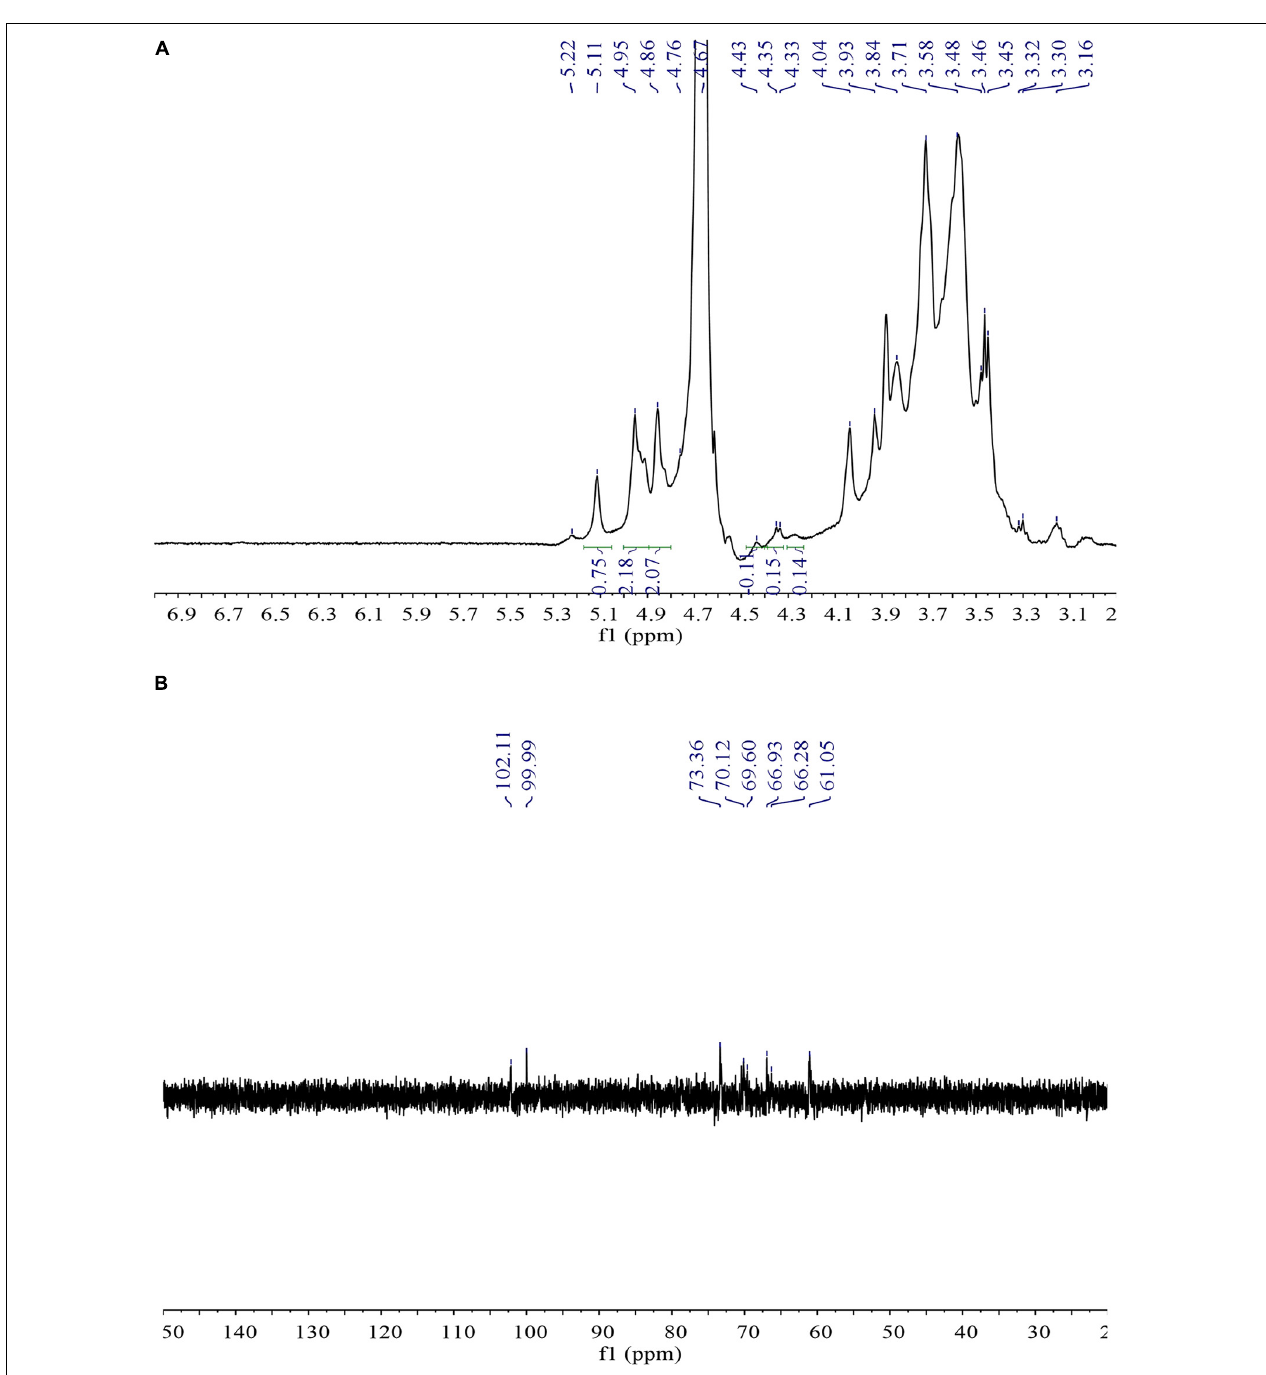
has been shown in Supplementary Figure 2 . The sharp and broad peak around 3,406.59 cm − 1 could be attributed to O–H stretching vibration. The signal at 1,652.69 cm − 1 indicated that C=O stretching vibration was possibly the characteristic absorption of polysaccharides (Kaur and Kapoor, 2008; Majumder et al., 2009). The absorption peaks at